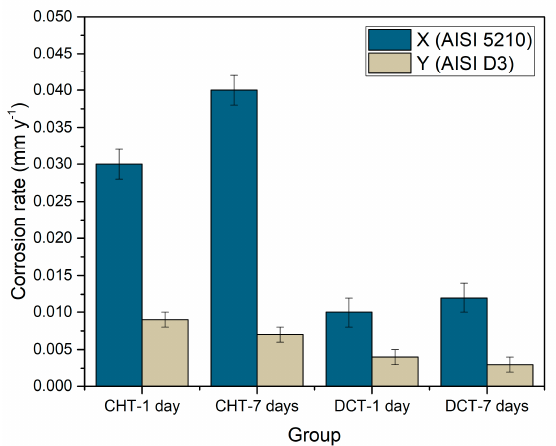
Figure 8. Graphical representation of corrosion rate of conventional and deep cryogenic heat-treated samples of steel X (X1–X2) and Y (Y1–Y2).